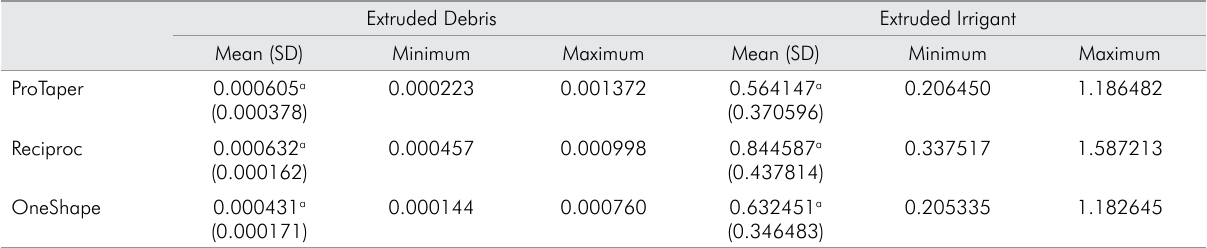
Table 1. Amount of Apically Extruded Debris (gram) and Irrigant (milliliter) after Use of the Different Instruments.